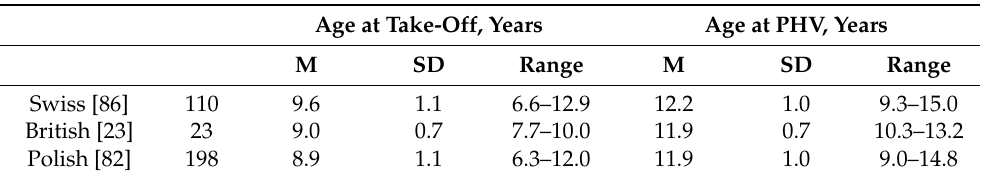
Table 4. Means (M), standard deviations (SD) and ranges for ages at take-off (initiation) of the growth spurt and at PHV in three longitudinal series of European